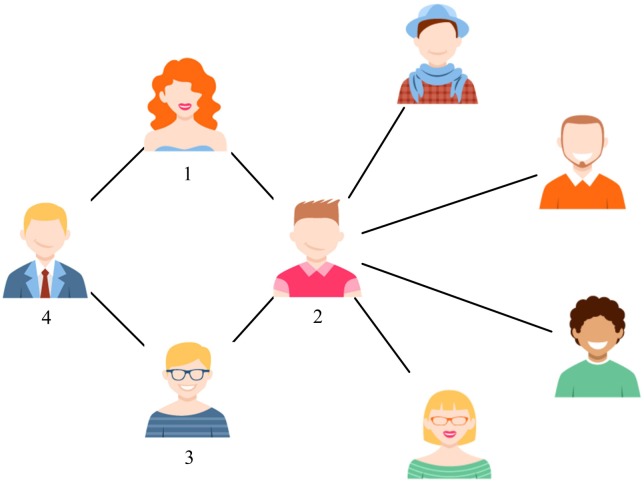
Example of similarity (b).